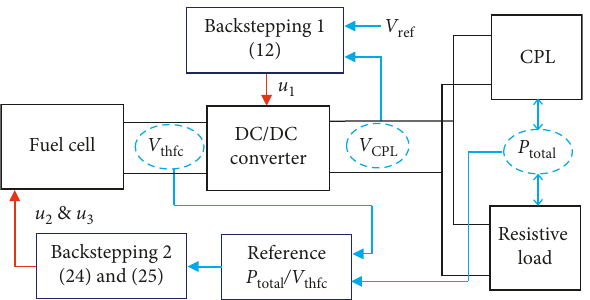
Figure 3: The overall schematic of the proposed control